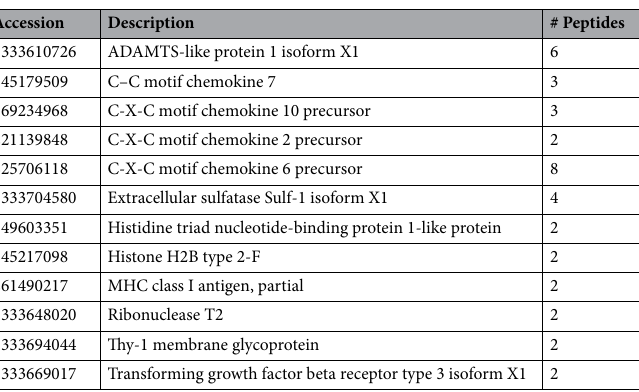
Table 2. Peptides with a known tumor suppressor function detected exclusively in fresh, non-cryopreserved eqMDEC conditioned medium